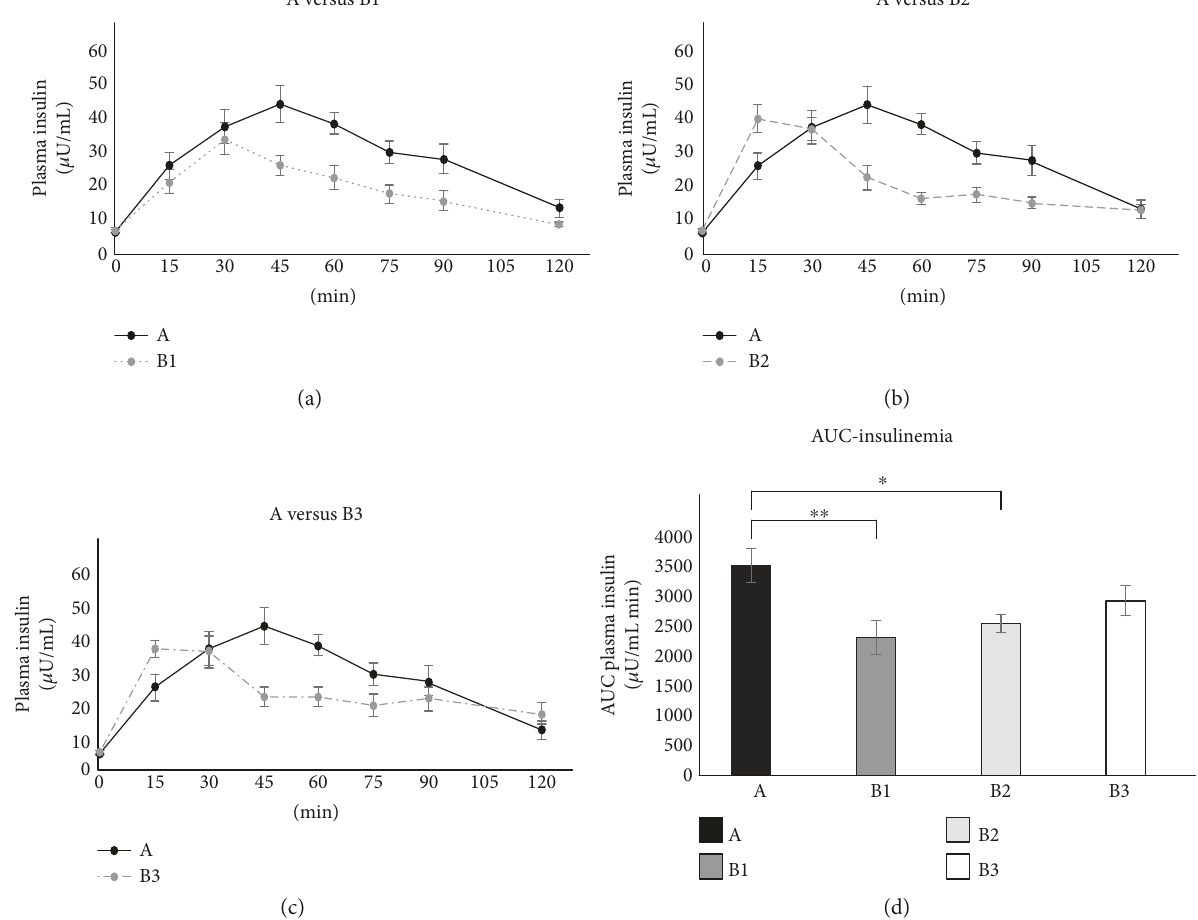
Figure 2: The time courses of insulin concentrations following breakfasts (a) B1, (b) B2, and (c) B3, respectively. For the sake of comparison, each of the three panels also displays the time course of insulin concentration measured after glucose ingestion (black line, glucose). (d) The AUC of glycemia for each test. ∗ p < 0 05 ; ∗∗ p < 0 01